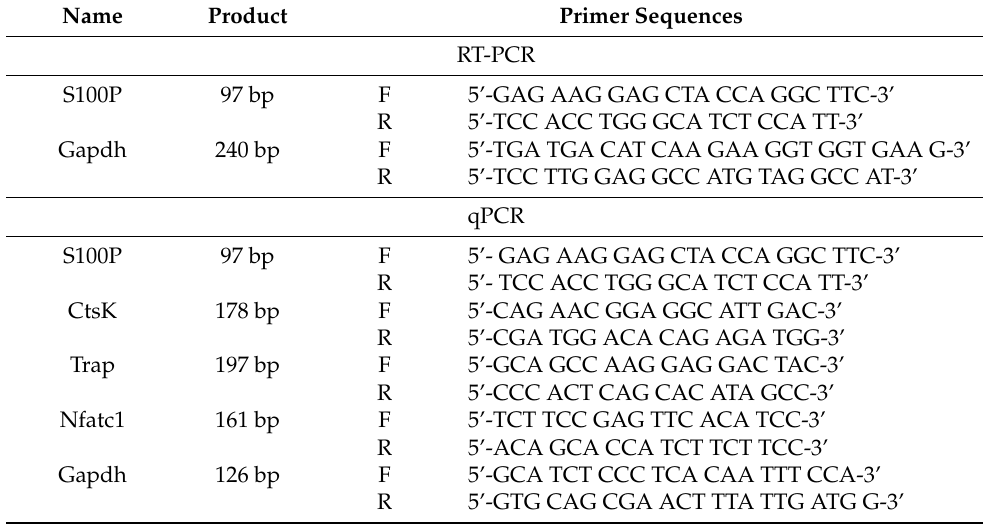
Table 2. Primer sequences for RT-PCR and